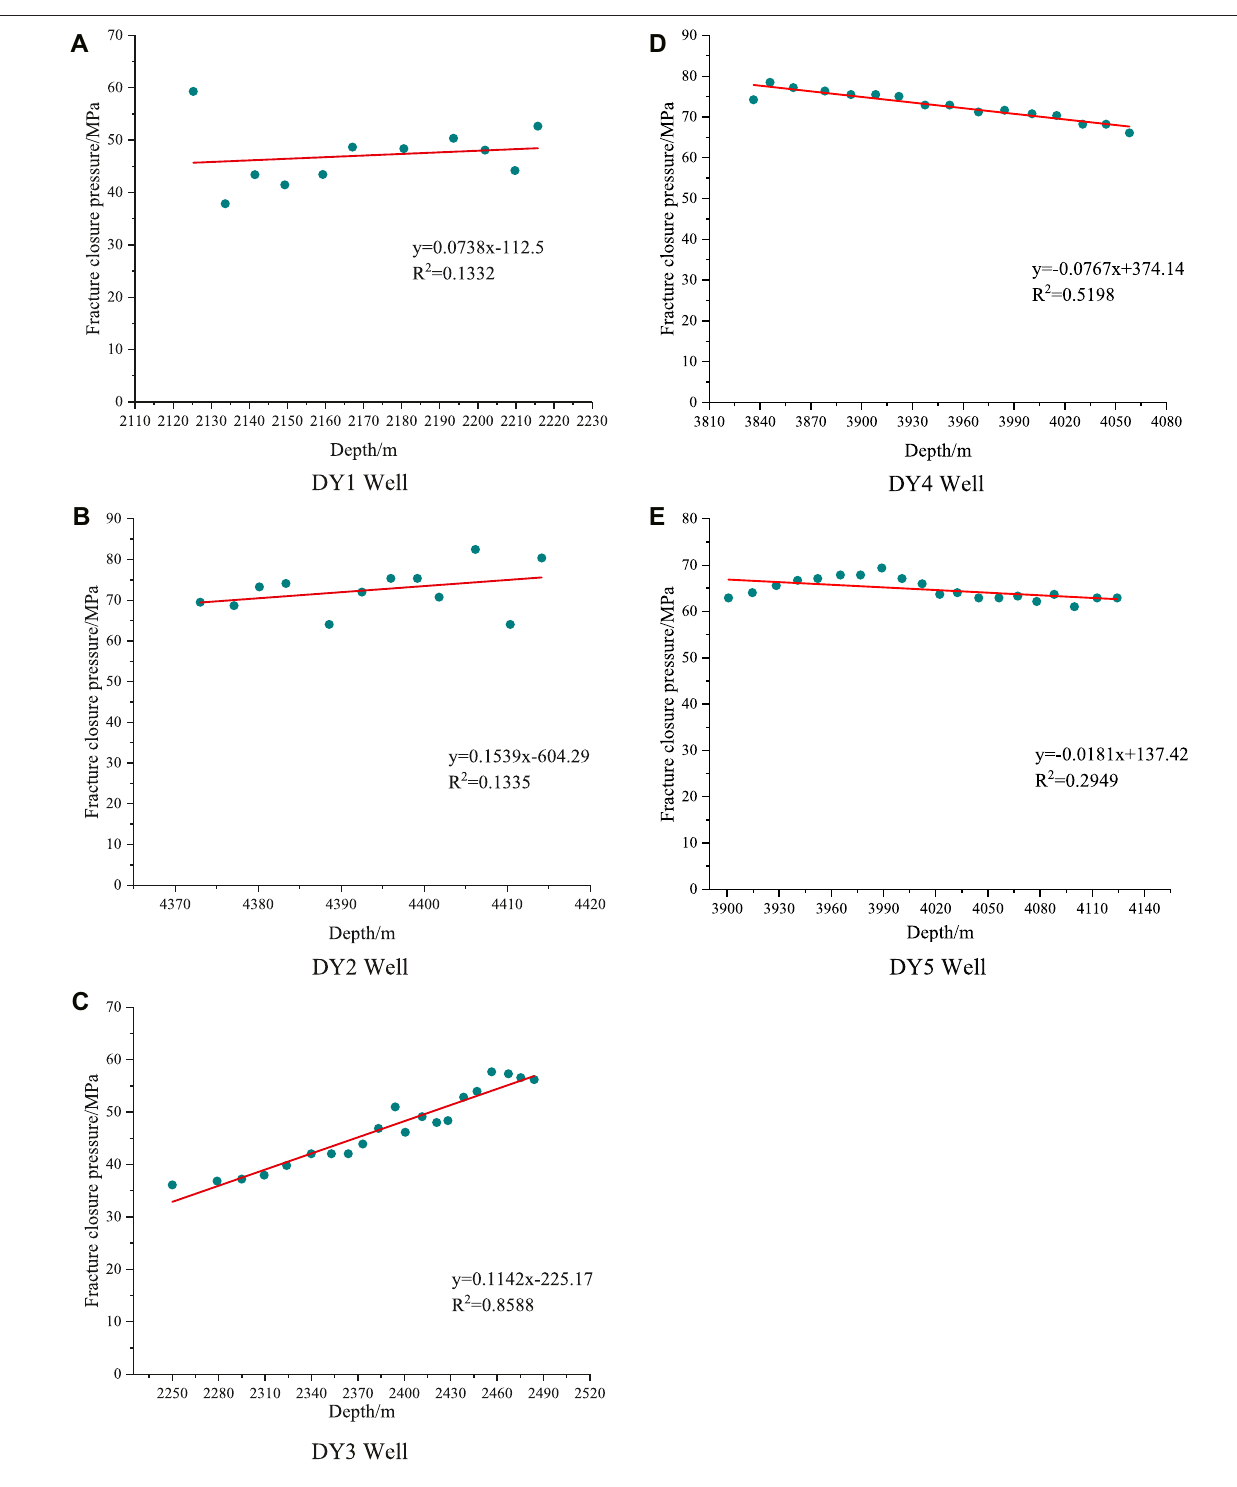
closure pressure and depth was obtained and plotted, as shown in Figure 6 . As observed, there is a certain correlation between the fracture closure pressure and depth. The fracture closure pressure